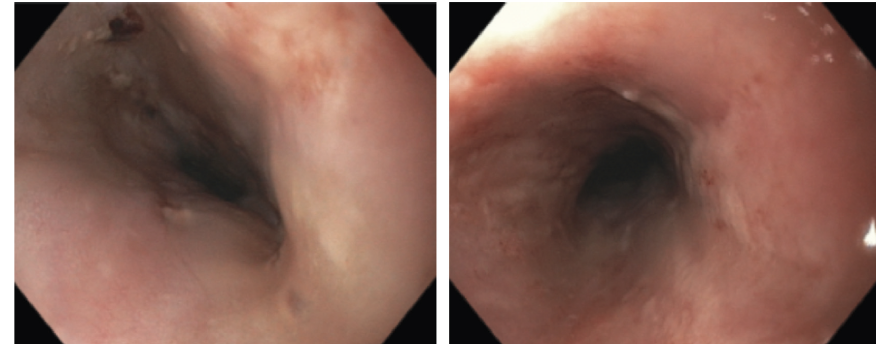
Figure 1: Images of esophagogastroduodenoscopy performed just prior to exploratory laparotomy and gastrostomy for evaluation of complete evacuation of foreign bodies in esophagus depicting irritation of the esophagus.